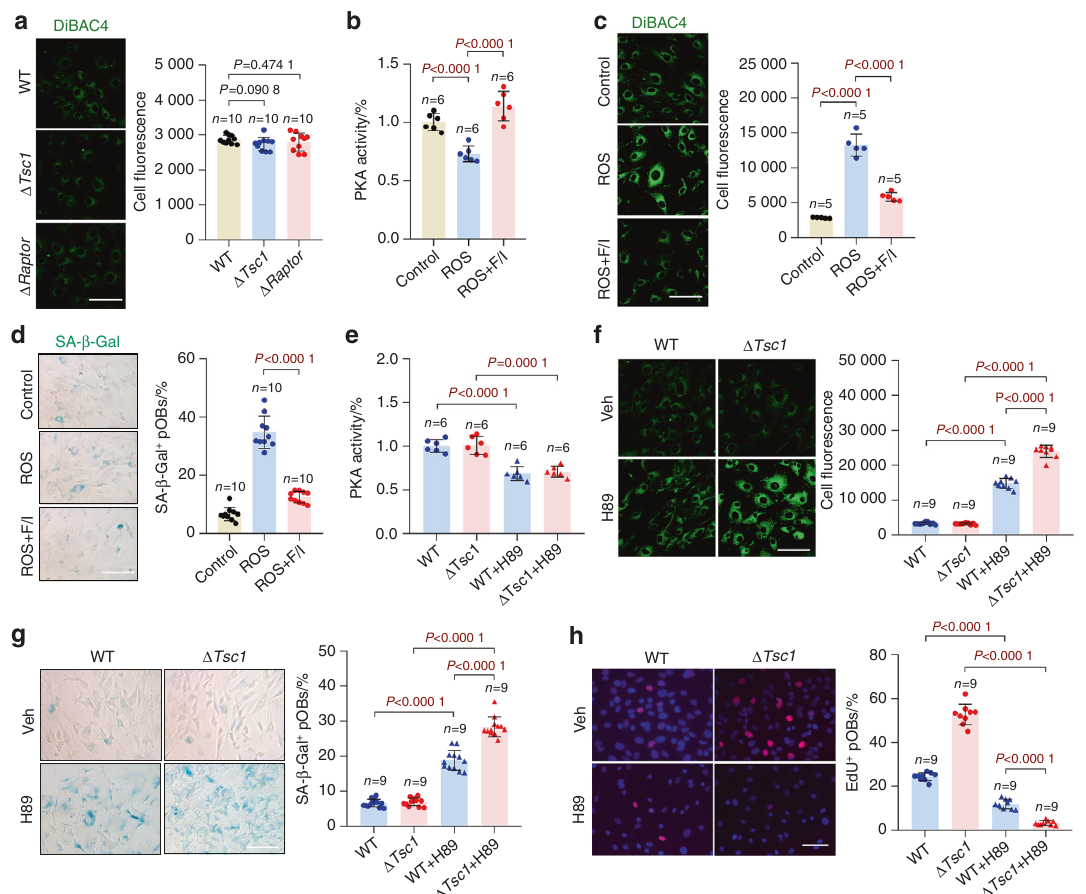
Fig. 7 Prosenescent stress activates Scn1a by inhibiting PKA. a Replicative wild-type (WT), Δ Tsc1 and Δ Raptor calvarial osteoblasts were incubated with the fl uorescent DiBAC4 dye and photographed under a confocal microscope. Scale bar, 50 μ m. Relative plasma membrane potentials were measured. ROS-induced senescent wild-type preosteoblasts were treated with F/I (forskolin + IBMx, PKA activator) or left untreated. The cells were subjected to ( b ) measurement of total cellular PKA activities, ( c ) DiBAC4 staining and measurement of relative plasma membrane potentials. Scale bar, 50 μ m. d SA- β -gal staining of cells in b and quanti fi cation of the proportion of SA- β -gal-positive cells in each population. Scale bar, 100 μ m. Replicative WTand Δ Tsc1 osteoblasts were treated with H-89 (PKA inhibitor) and were subjected to ( e ) measurement of total cellular PKA activities, ( f ) DiBAC4 staining and measurement of relative plasma membrane potentials. Scale bar, 50 μ m. g SA- β -gal staining of cells in e and quanti fi cation of the proportion of SA- β -gal-positive cells in each population. Scale bar, 100 μ m. h Immunostaining of EdU in cells in e and quantitative analysis of EdU + cells relative to total cells. Scale bar, 100 μ m. Data are shown as the mean ± SD. The numbers of samples ( n ) are indicated in each fi gure panel. P values were determined by two-tailed Student ’ s t test for single PKA activity during cell senescence. Prosenescent stresses elevate the permeability of Scn1a to Na + by suppressing PKA activity and markers (Fig. 8m – o) in the Δ Tsc1 preosteoblasts. These results suggested that plasma membrane depolarization causes preos- teoblast senescence by increasing Ca 2 + in fl ux and activating NFAT/ATF3/p53 signaling.